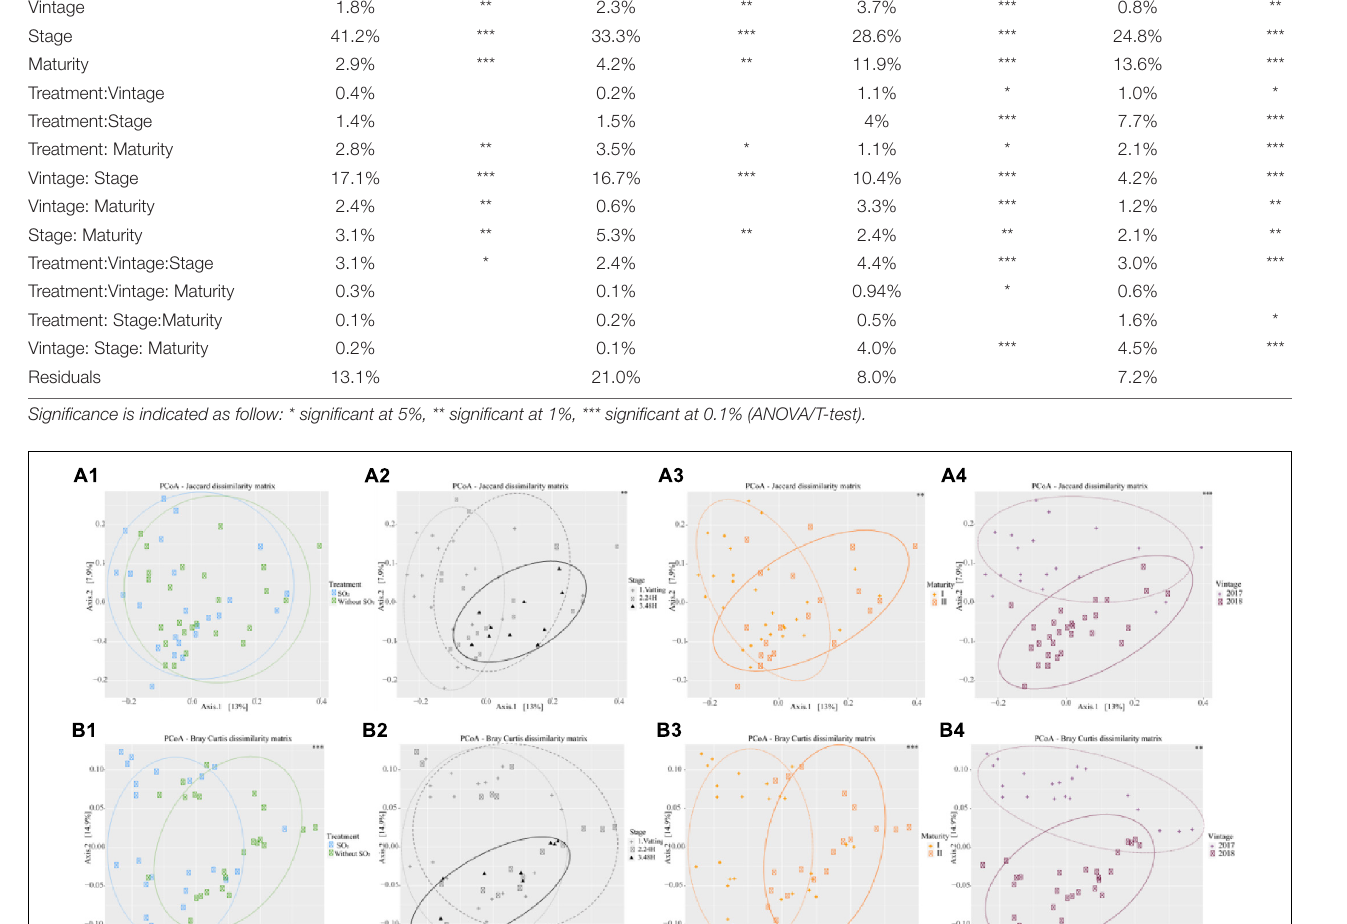
TABLE 1 | Percentage of variance explained by Treatment (Without SO 2 , SO 2 and Bioprotection), Stage, Vintage, Maturity factors and these interactions for different α biodiversity indices. Observed Chao1 Shannon InvSimpson Treatment